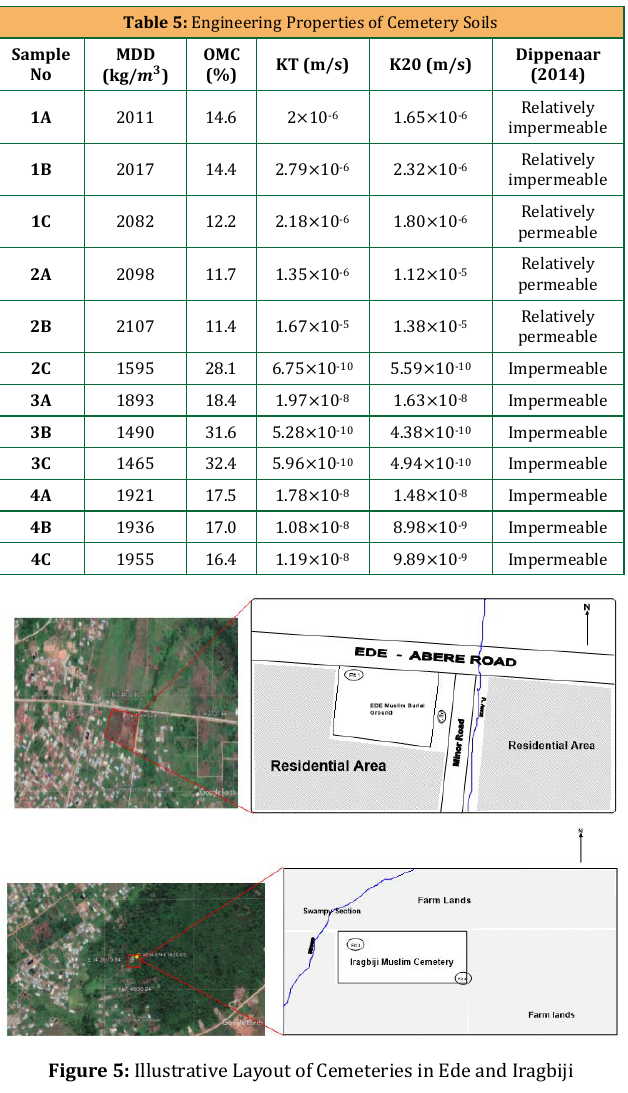
Illustrative Layout of Cemeteries in Ede and Iragbiji